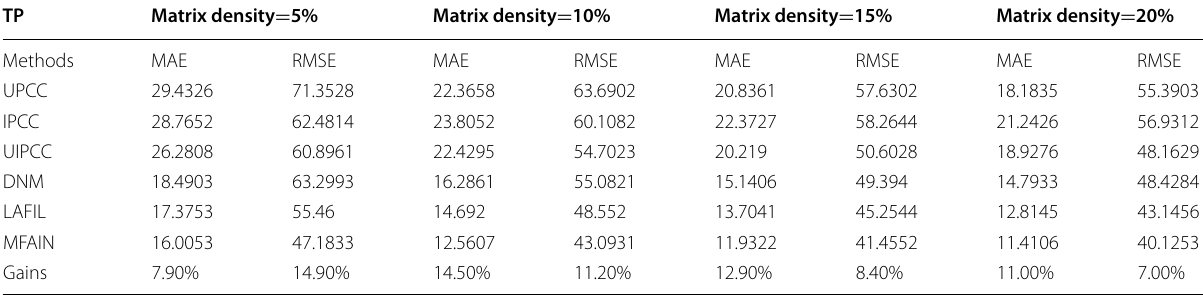
Table 5 Performace comparison for throughput